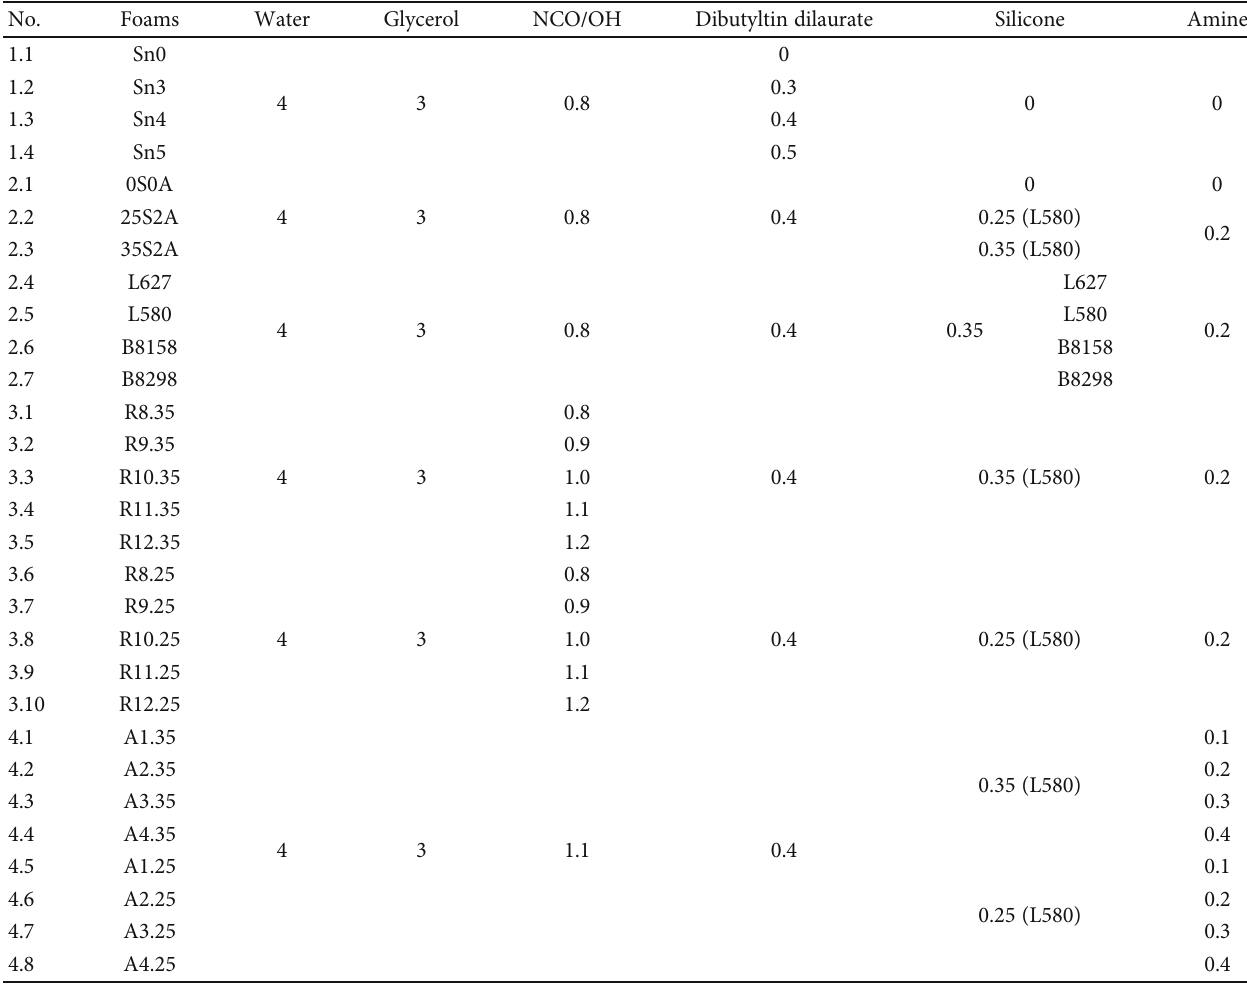
Table 1: Formulation of rigid polyurethane foam based on rubber seed